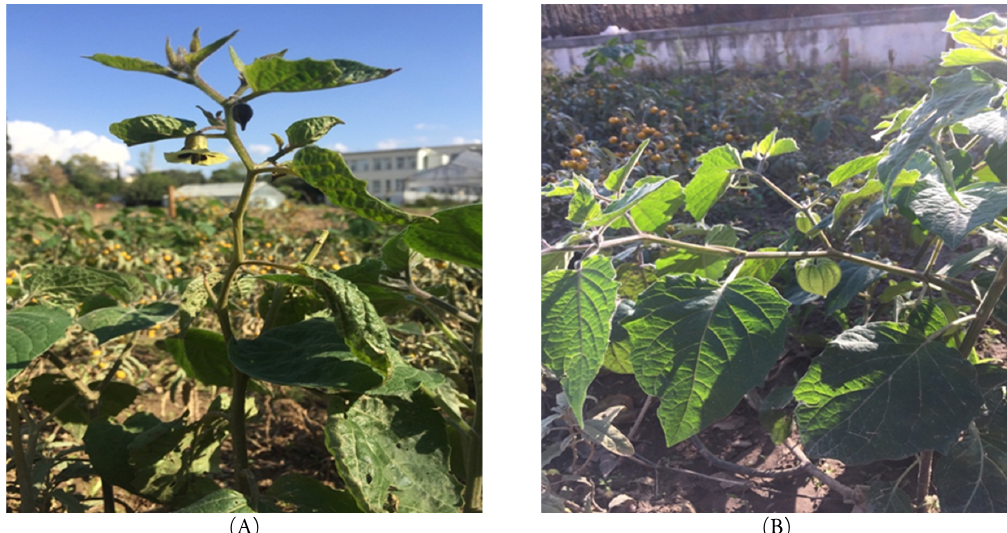
Figure 2. P. peruviana at (A) flowering and (B) fruit formation stage, respectively Growth, Yield and Yield Parameters of P.